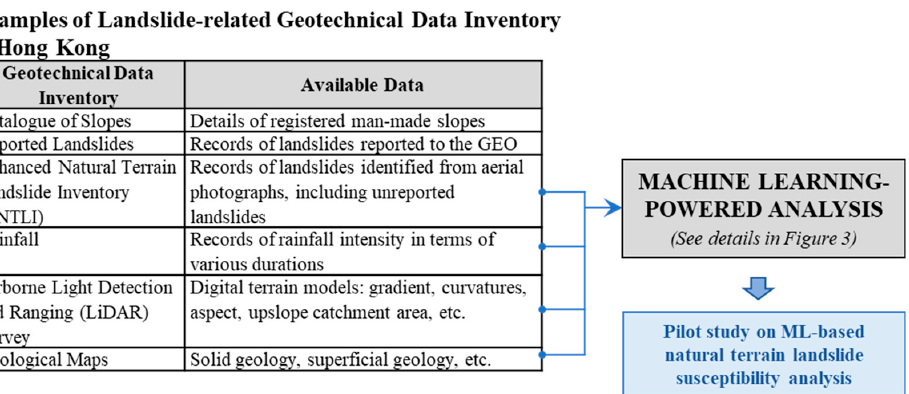
Figure 1. Data inventories considered in the exploratory study.